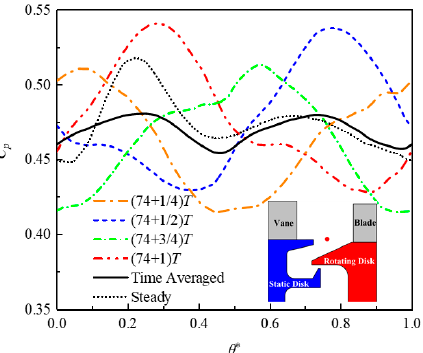
Figure 10. Transient and steady static pressure coefficient distribution along the circumferential di- rection at the clearance outlet (Seal-A and IF = 0.6%). direction at the clearance outlet (Seal-A and IF = 0.6%).